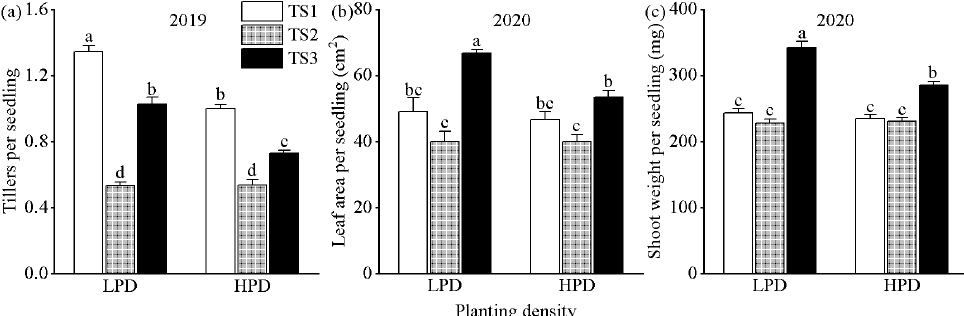
Figure 2. Effects of the combinations of planting density and method of tillage and sowing on ( a ) tillers per seedling in 2019, ( b ) leaf area per seedling in 2020, and ( c ) shoot weight per seedling in 2020 at the beginning of the over-wintering stage in the 2019 and 2020 seasons. Data are presented as means ± standard errors, and the bars above the columns are standard errors. The different letters on the bars indicate significant differences at the 0.05 probability level.